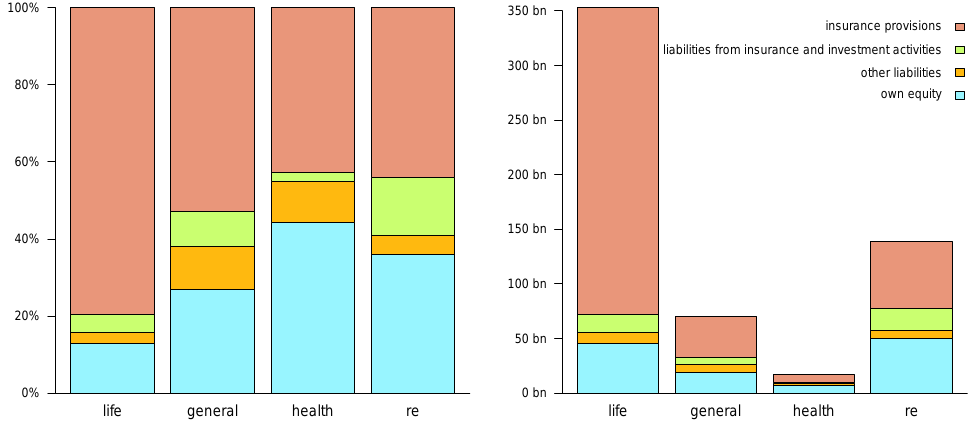
Figure A1. Aggregated balance sheets for each branch of insurance as used for the case study. Assets ( top ) and liabilities ( bottom ). Values on (lhs) are relative and in percentage, values on (rhs) are absolute and in billion CHF.